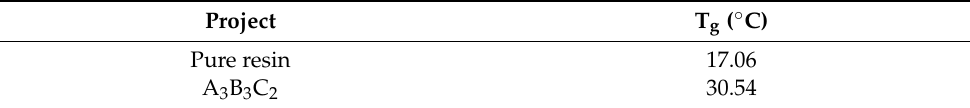
Figure 7. Storage modulus-temperature spectrum and loss factor − temperature spectrum of different groups of PU-ER: ( a ) Storage modulus-temperature spectrum; ( b ) Loss factor − temperature spectrum. Table 9. Glass transition temperature of resin before and after adding filler.